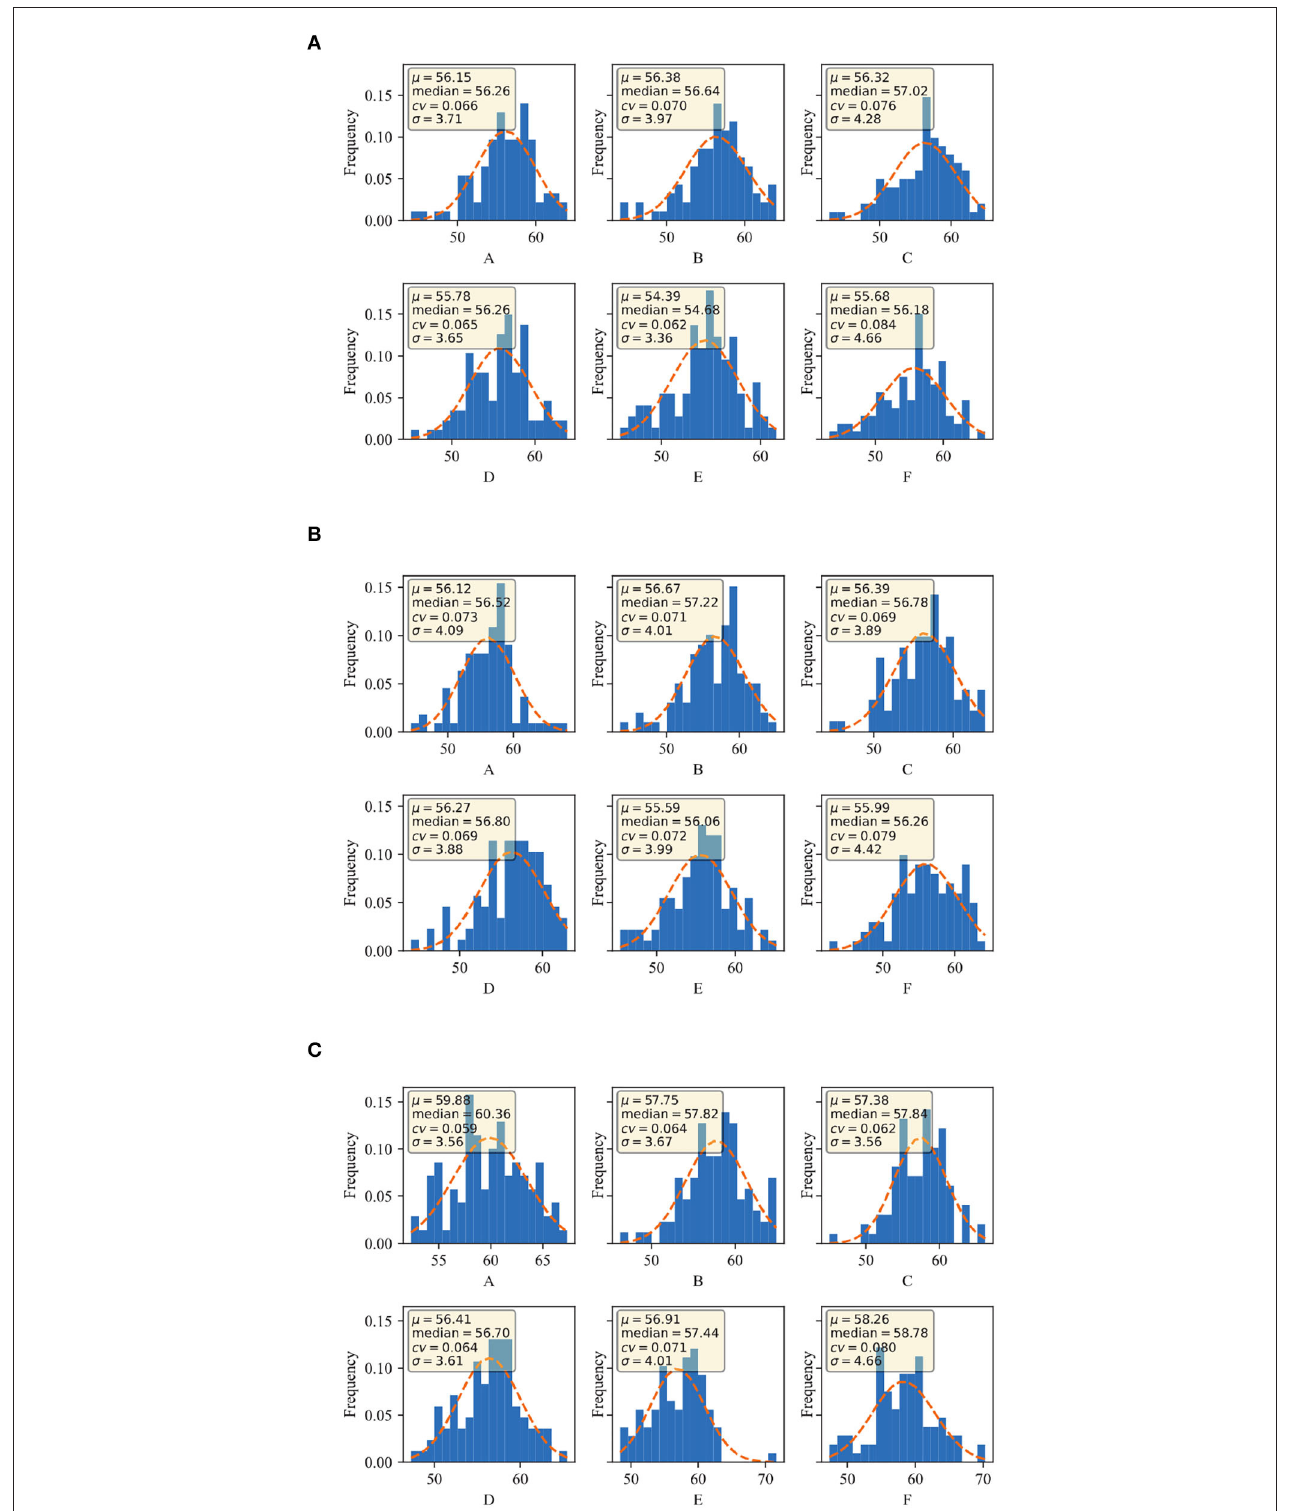
FIGURE 4 | CC distribution of different growing stages of Manas winter wheat: (A) heading stage of Manas winter wheat; (B) flowering stage of Manas winter wheat; and (C) filling stage of Manas winter wheat. A–C denote three replicates under normal irrigation; D–F denote three replicates under water-limited treatment.